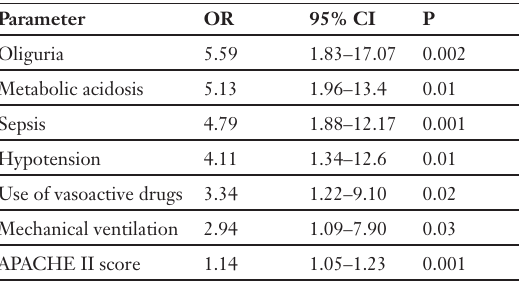
Independent risk factors for death in critically ill patients with infectious disease-associated acute kidney